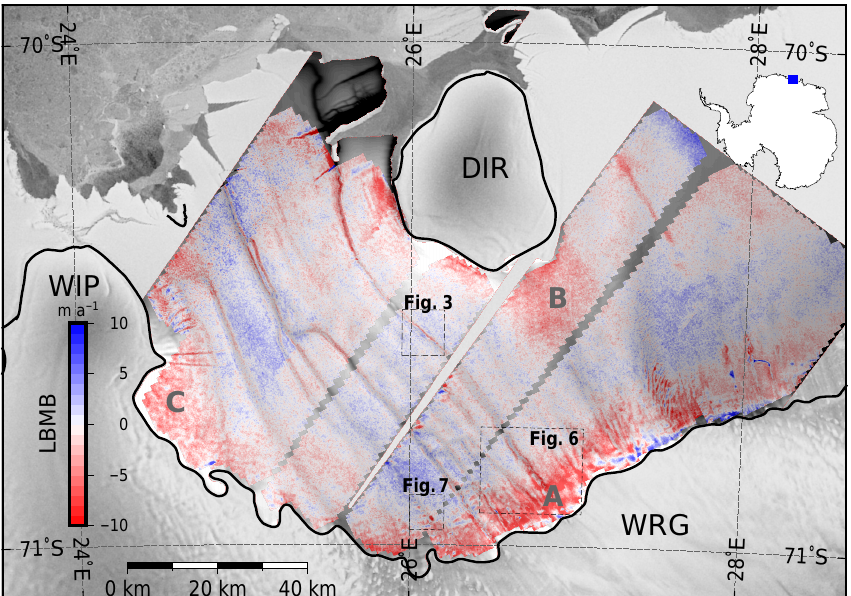
Figure 4. Lagrangian basal mass balance (LBMB) of the Roi Baudouin Ice Shelf. Red and blue colours indicate basal melting and refreezing, respectively. The three dashed boxes locate the close-ups presented in Figs. 3, 6 and 7. Labels A–C pinpoint areas discussed in the text. Acronyms: DIR, Derwael Ice Rise; WIP, Western Ice Promontory; WRG, West Ragnhild Glacier. The LBMB overlays the 2014 TanDEM-X DEM. The background is from the Radarsat mosaic (Jezek and RAMP Product Team, 2002) and the black line delineates the grounding line (Depoorter et al.,